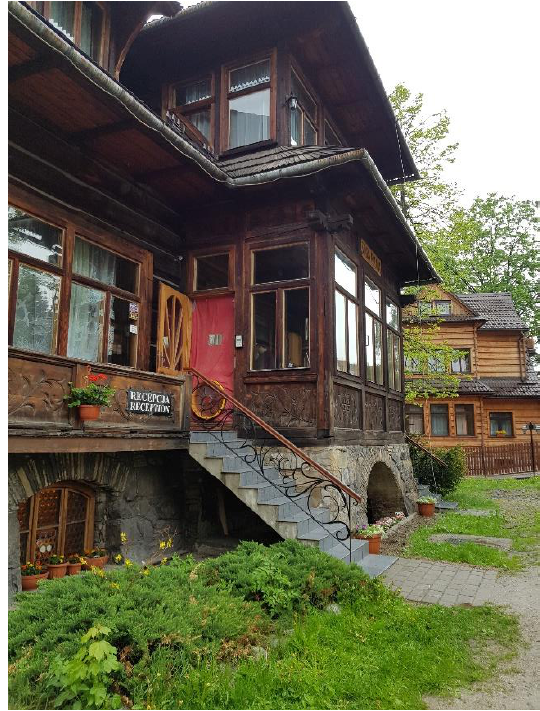
Figure 5. Leak test at the ‘Stara Polana’ hostel [30].